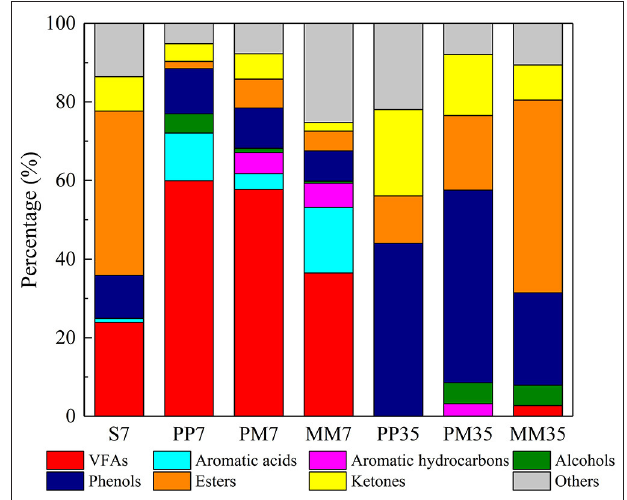
FIGURE 4 | The composition of organic matter in each sample revealed by GC-MS. S represents soaked coal with only anaerobic medium. PP represents the cultivations with PF pretreated coal for 7 days then added methanogenic microflora. PM represents the cultivations with raw coal and mixed culture of PF and methanogenic microflora. MM represents the cultivations with raw coal and methanogenic microflora. The 7 and 35 are incubation